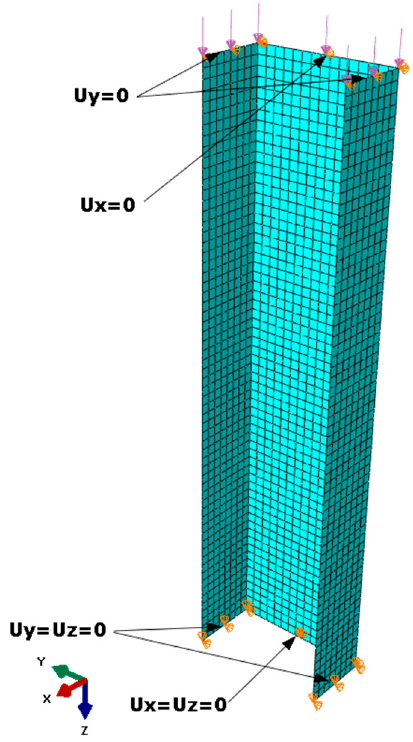
Figure 2. Boundary conditions from the discretised model (own work).